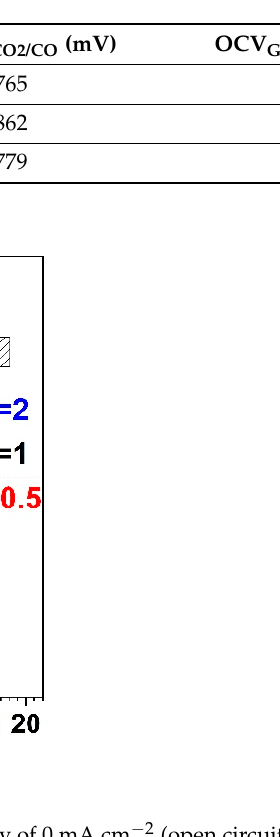
Table 2. Experimental OCV and calculated Nernst potential using both thermodynamic equilibrium gas compositions and experimental gas compositions for p( CO2-CO ) and p( H2O-H2 ) at open circuit voltage, at 900 ◦ C.